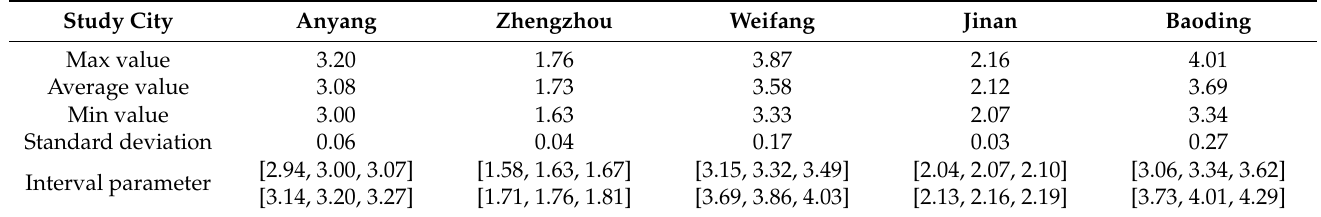
Table 6. Fuzzy interval parameters and statistical description of winter wheat planting areas (10 5 hectares) in five studied cities.